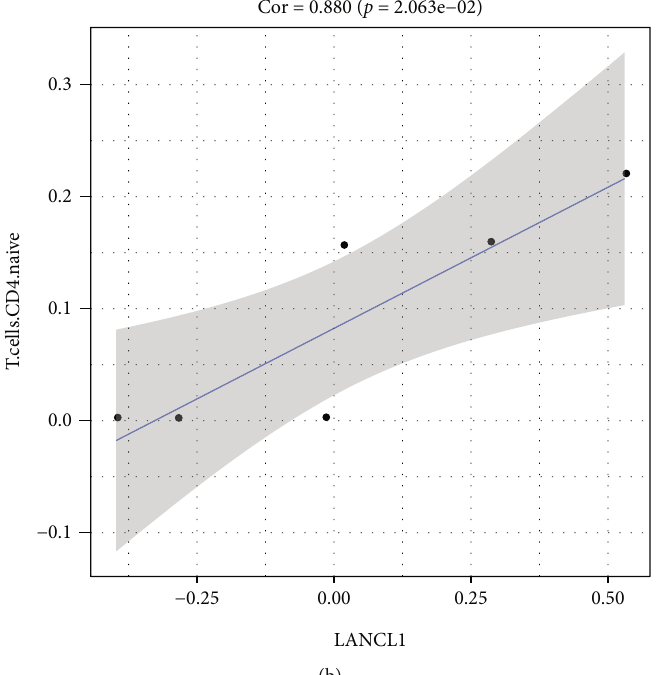
Figure 7: Correlation analysis results between genes and immune in fi ltrating cells: (a) correlation analysis of immune in fi ltrating cells; (b) correlation curve between LANCL1 and T cells CD4